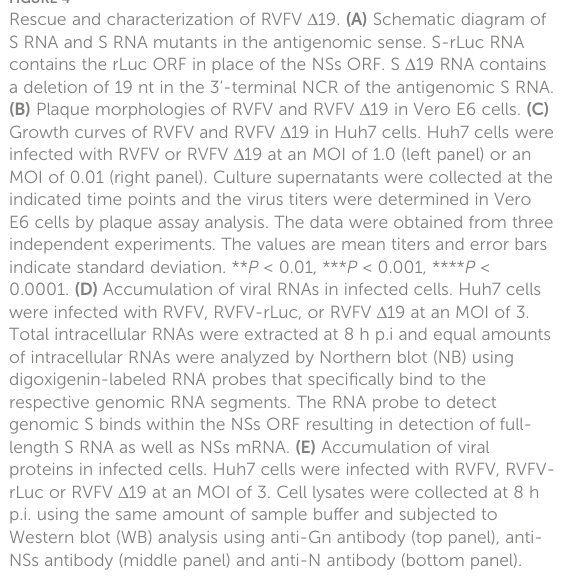
prominent Gn-binding site in the 3 ’ NCR of antigenomic S RNA plays a critical role in the ef fi cient packaging of antigenomic S RNA into virus particles.